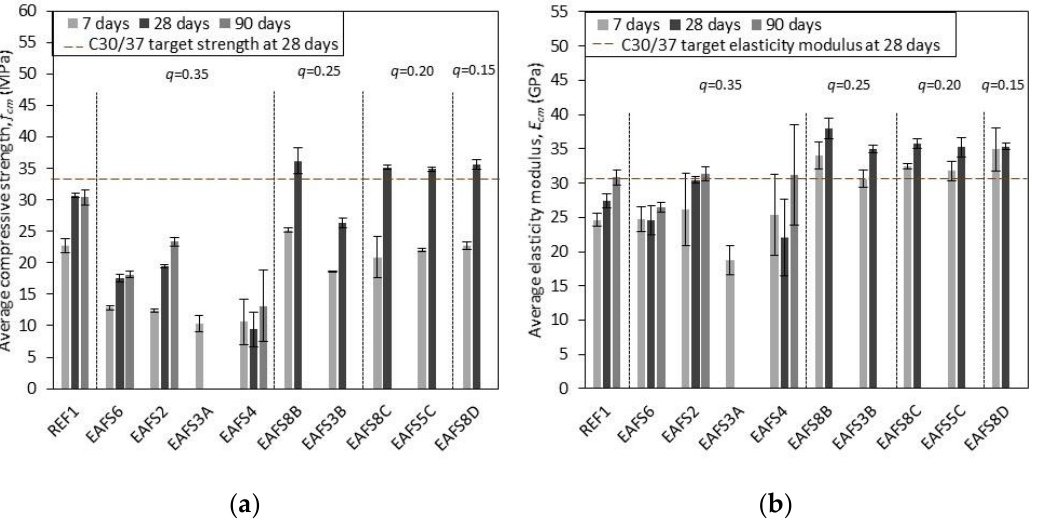
Figure 11. Mechanical testing results at 7, 28 and 90 days after casting for REF1 and EAFS mixtures with high cement amount: ( a ) average compressive strength, f cm ; ( b ) average elasticity modulus, E cm .